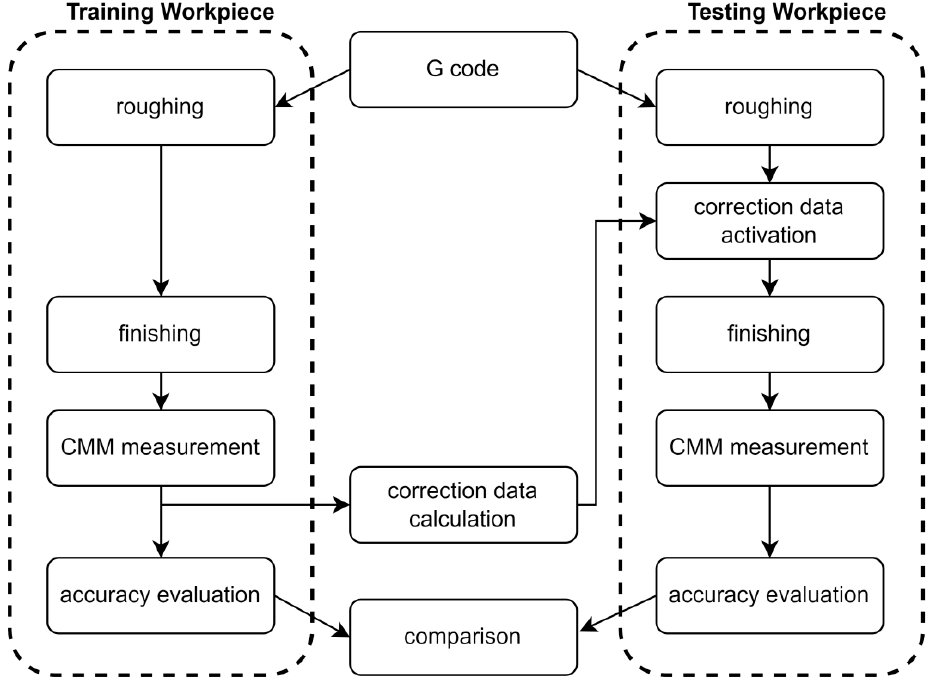
Figure 11. Flow chart of training and testing workpiece machining. Table 1. Cutting conditions for workpiece